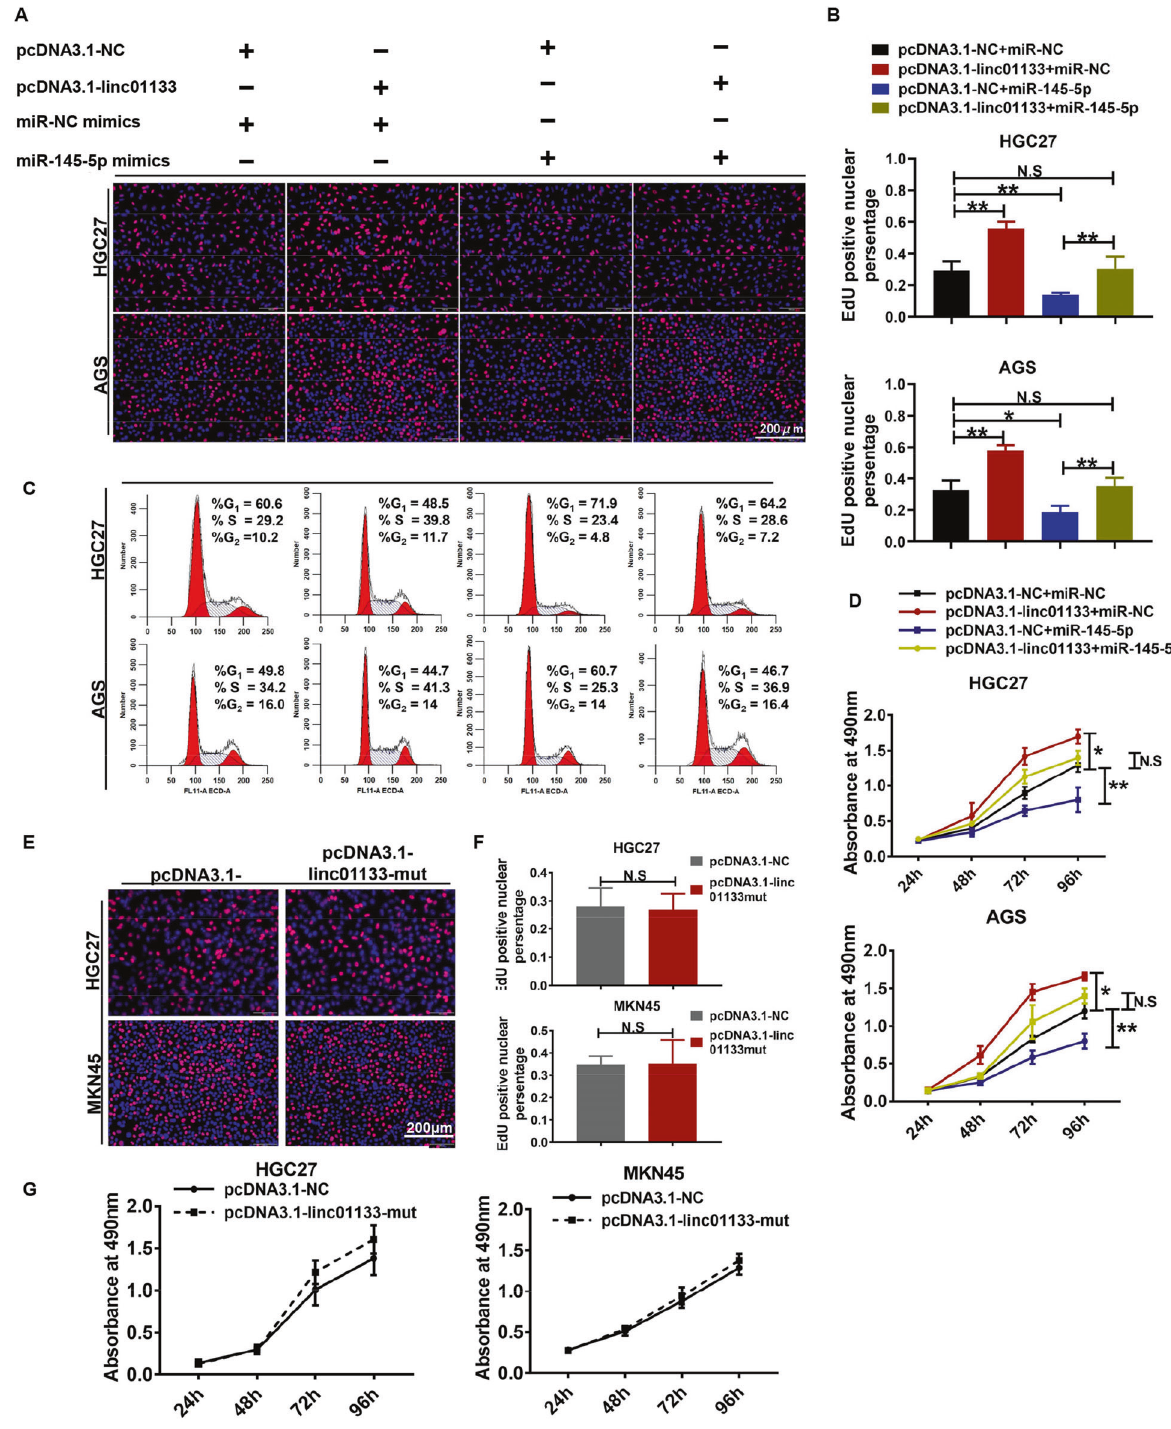
Fig. 4 Linc01133 functions as a ceRNA of miR-145-5p. miR-145-5p counteracted with linc01133 in the proliferation and cell cycle progression of gastric cnacer cells demonstrated by EdU ( A, B ), FASC ( C ) and MTS assay ( D ). Linc01133 with miR-145-5p binding sites mutation failed to accelerate the tumor cell growth demonstrated by EdU ( E, F ) and MTS ( G ). Each experiment was performed in triplicates. Data are shown as mean ± SD, * P < 0.05, ** P < 0.01, N.S no signi fi cance. cells were co-transfected with miR-145-5p mimics and linc01133 expression vector, the YES1 down-regulation by miR-145-5p mimics was greatly attenuated by linc01133 expression (Fig. 5L). Collectively, YES1 is a common target of miR-145-5p and linc01133. accelerating cell growth completely as demonstrated by EdU and